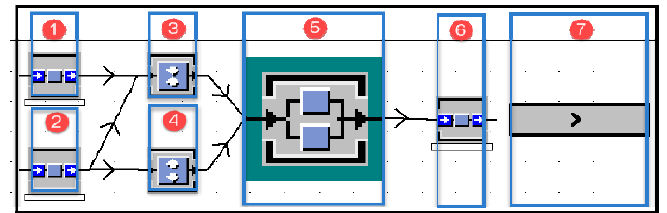
Figure 2. Technological objects class.